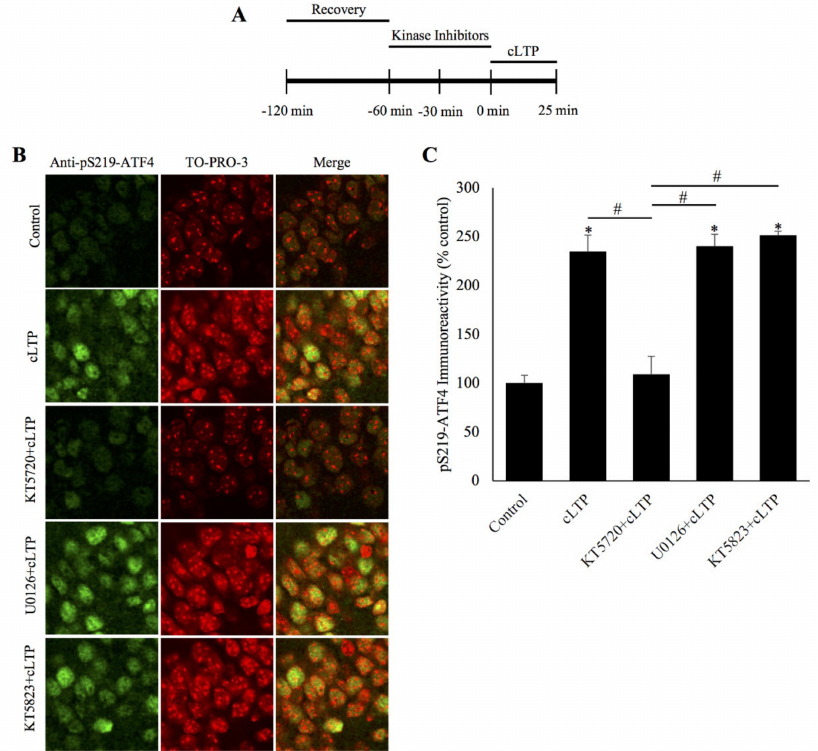
Figure 2. ATF4 is phosphorylated by protein kinase A during chemically induced long-term potentiation. ( A ) Schematic outline of the experiment: during the second hour of the recovery period, the slices were incubated with a kinase inhibitor. The beginning of cLTP induction is designated as 0